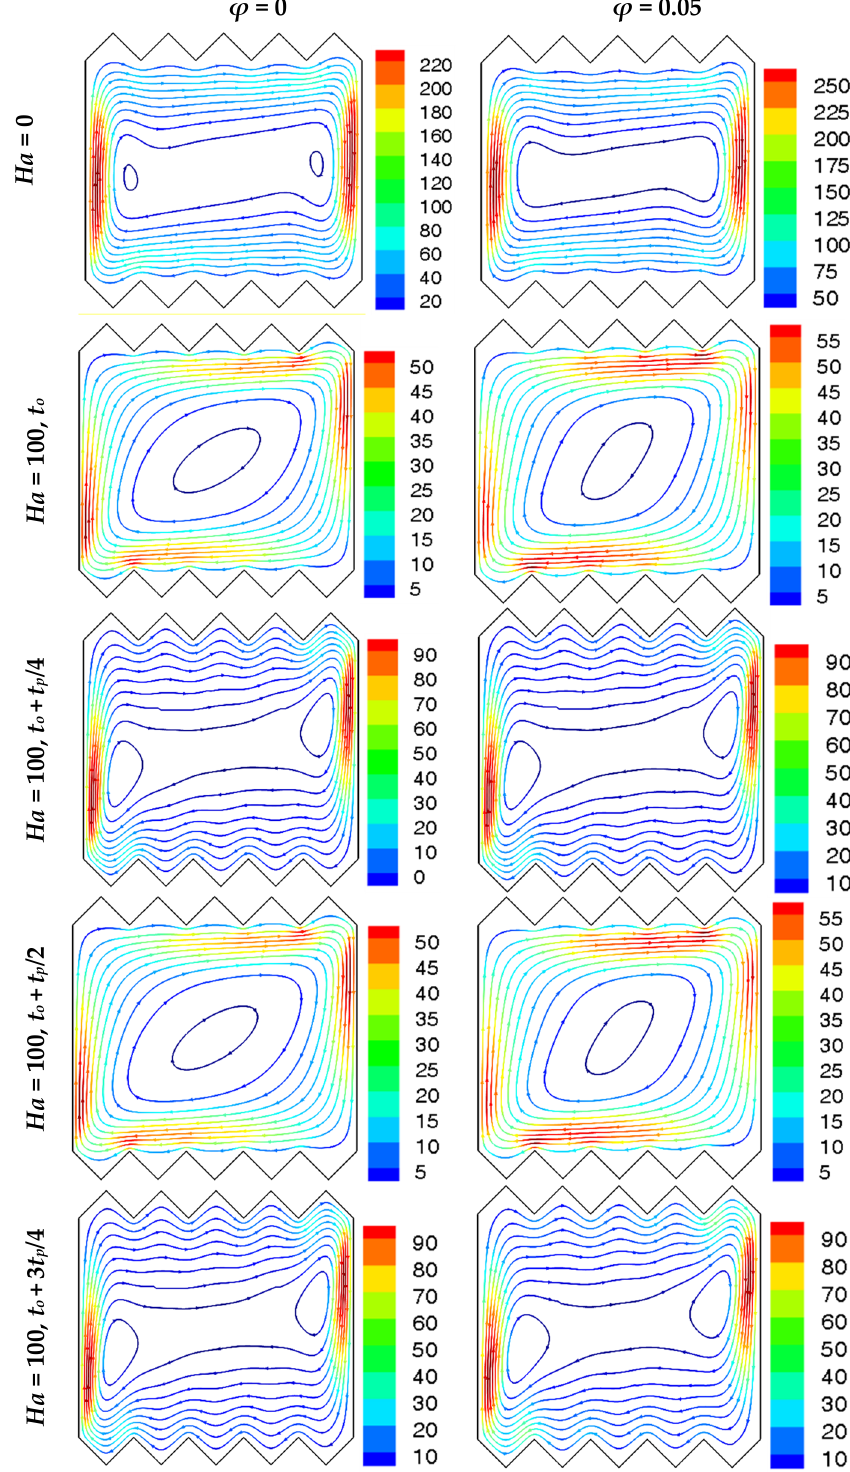
Figure 4. Streamlines for Ha = 0 and Ha = 100 for Ra = 10 6 , f = 4 and A/L = 0.1.